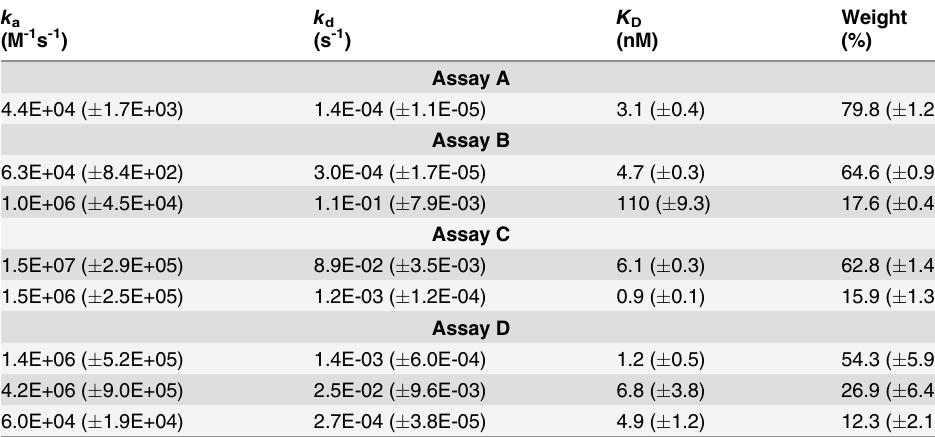
Table 2. Kinetic interaction parameters calculated by Interaction Map.